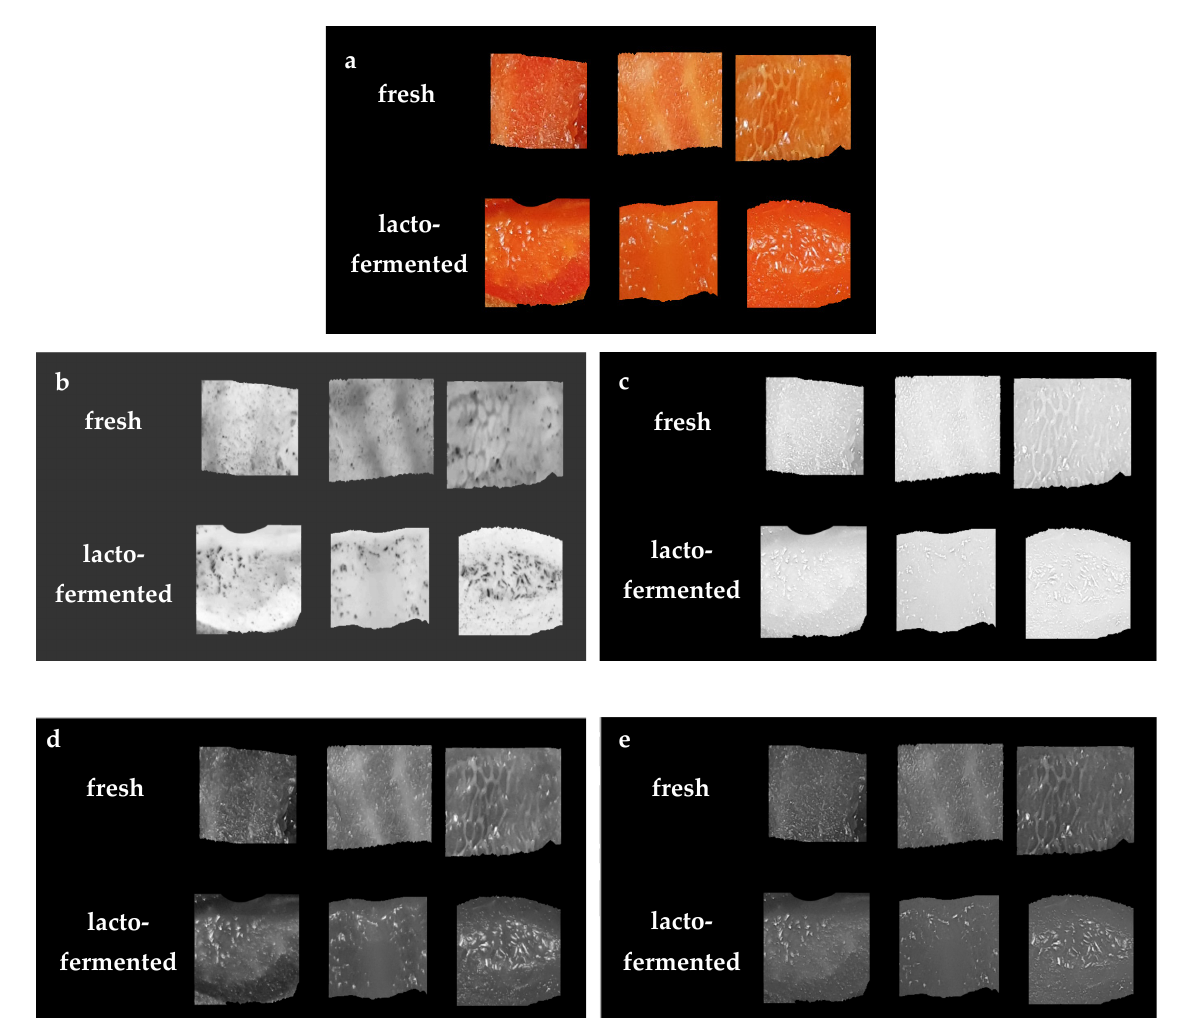
Figure 2. The original digital color images of samples of fresh and lacto-fermented bell pepper ( a ) and images converted to selected color channels: a ( b ); R ( c ); G ( d ); X ( e ). The regions of interest (ROIs) were overlaid. An ROI was considered as a set of pixels separated from the background. The segmentation of the image into lighter pepper pieces and the black background was performed using the brightness threshold which was de- termined manually. Each ROI was one whole piece of pepper. Thus, 200 ROIs including 100 ROIs of fresh samples and 100 ROIs of lacto-fermented samples were determined. For each ROI, 1629 image textures were computed including 181 textures for each color chan- nel. The texture parameters were computed on the basis of the co-occurrence matrix (132 textures including 11 features for four directions and three between-pixel distances), run- length matrix (20 textures including five textures for four directions), Haar wavelet trans- form (10 textures), histogram (nine textures), autoregressive model (five textures), ad gra- dient map (five textures). Among the color channels of images selected for the texture extraction, color channels R (red), G (green), and B (blue) belonged to the RGB color space, channels L (lightness from black to white), a (green for negative and red for positive val- ues), and b (blue for negative and yellow for positive values) belonged to the Lab color space, and channels X (a component of color information), Y (lightness), and Z (a compo- nent of color information) belonged to the XYZ color space [28]. The computed image textures were considered as a function of the spatial variation of the pixel brightness in- tensity and provided information about the structure of the samples. Thus, the quantita-